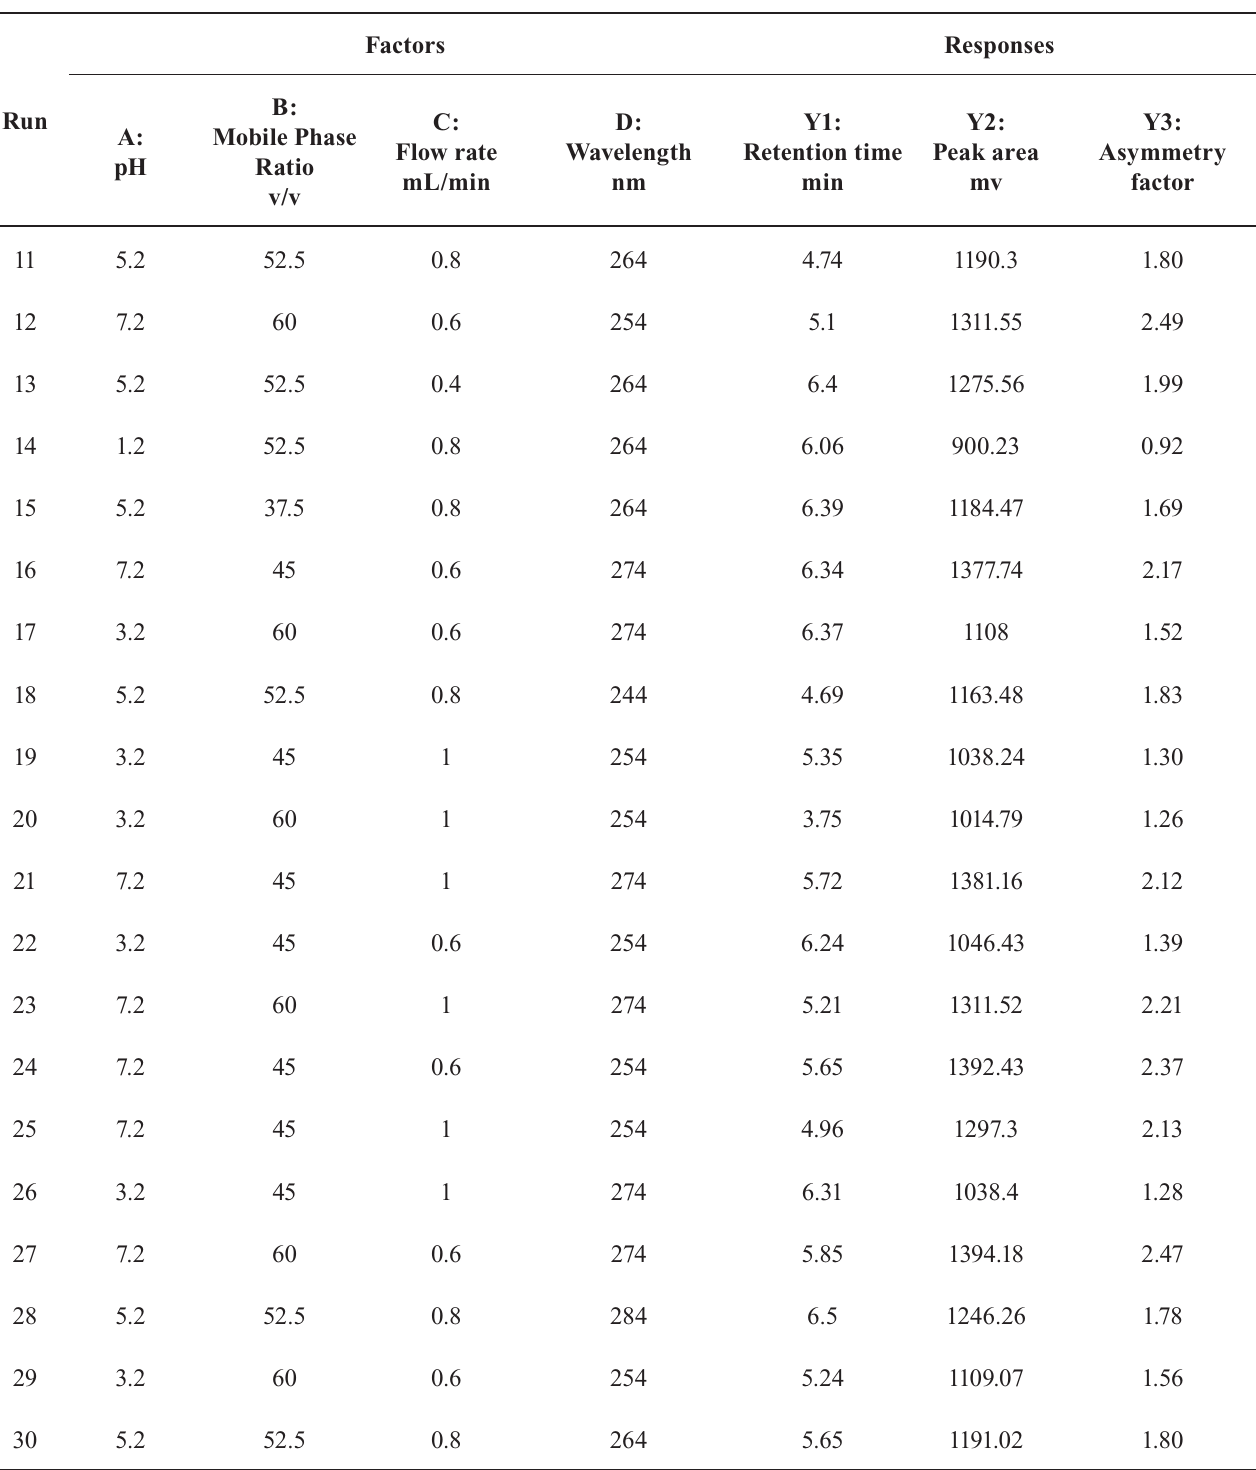
TABLE II - Optimization method parameters for central composite design